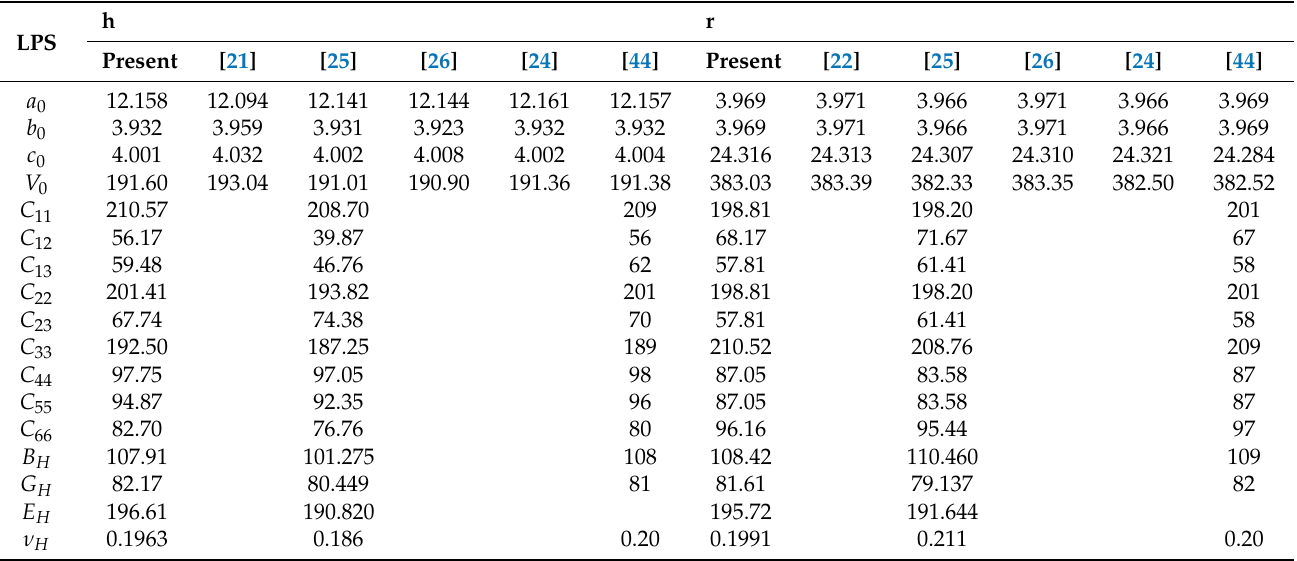
Table 1. Calculated bulk properties of the LPSs h- and r-Al 2 Ti at 0 GPa and 0 K, togerther with available experimental and theoretical